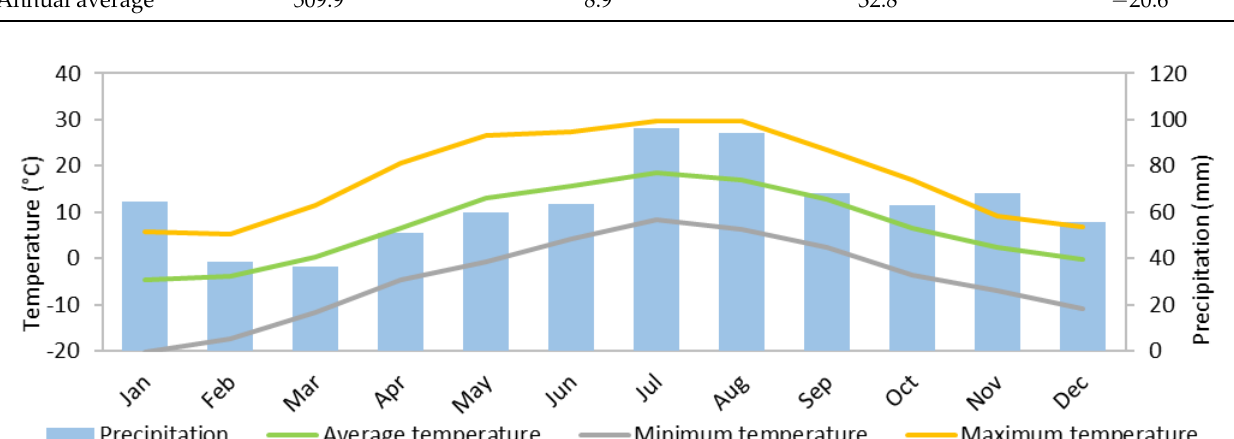
Figure A1. Average monthly climatic conditions of the study site located in Latvia during the study period 2011 – 2018.